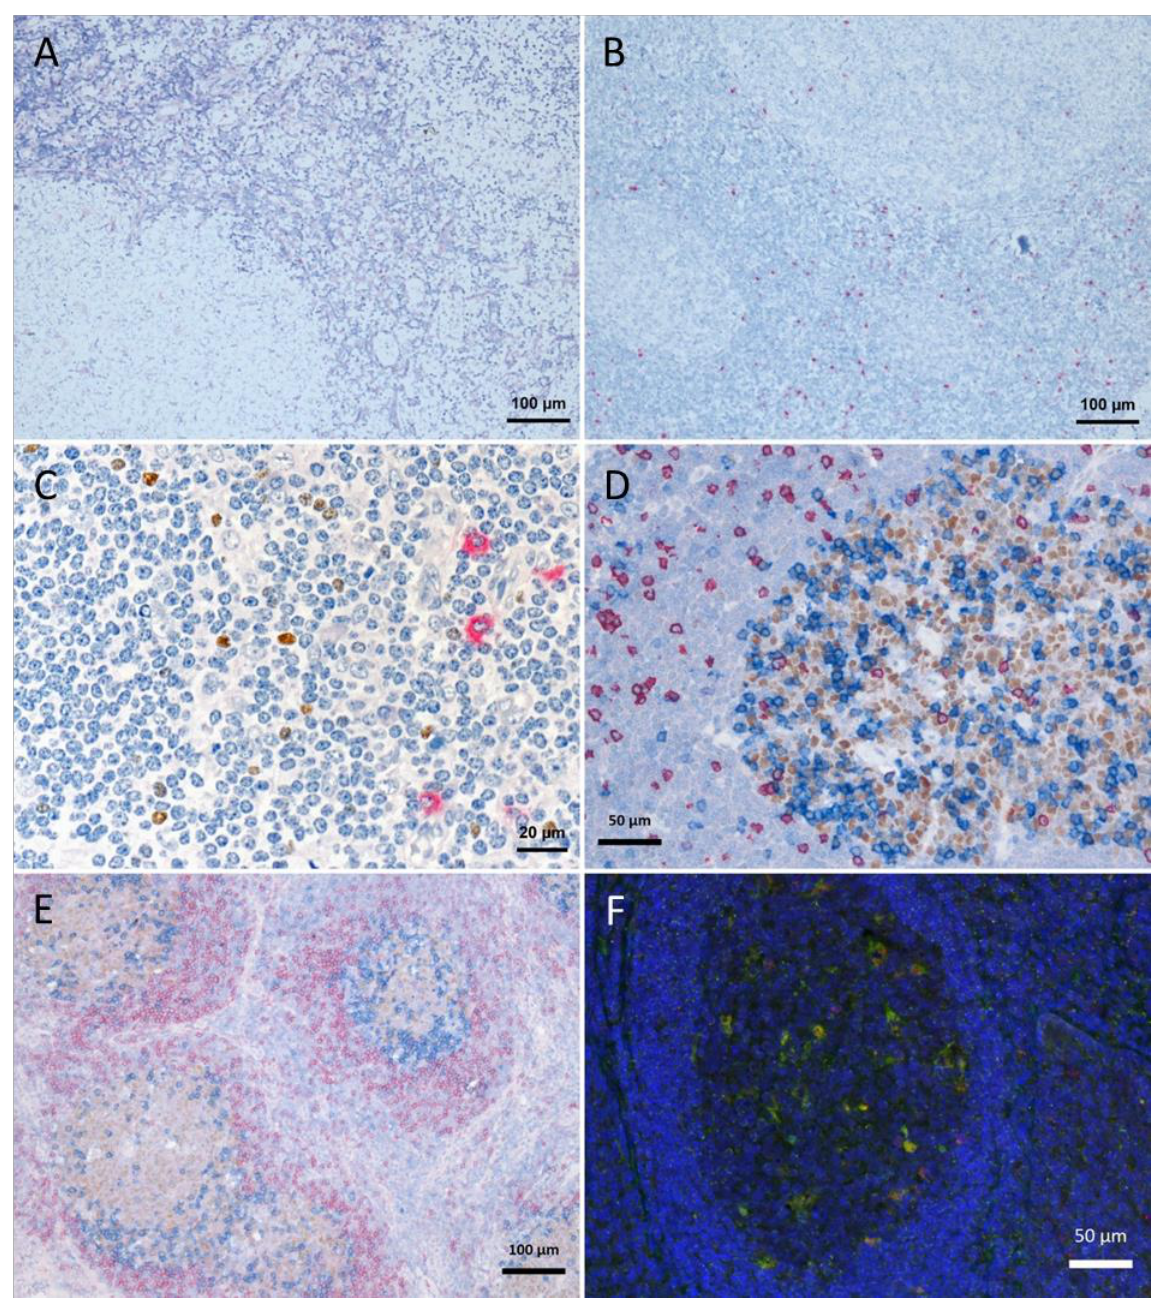
Figure 1. Tissue degradation and signal loss vs. preserved tissue and signal with refixation. ( A ) FoxP3 staining (brown) after 5 min retrieval in high pressure cooker in citric buffer pH 6, followed by KLRG1 (red) after proteinase K pretreatment and ( B ) vice versa (proteinase K followed by high pressure cooking) lead to strong tissue degradation. ( C – F ) show examples with refixation between the retrievals. ( C ) Protocols from ( B ) with interposed refixation step lead to preservation of tissue structure with maintained signals (KLRG1 red, FoxP3 brown). ( D , E ) Examples of triple staining with up to two retrievals: ( D ) human tonsil, CD8 (red, 2 min high pressure cooking) followed by Bcl6 (brown, 5 min high pressure cooking) together with PD1 (blue, cocktail with Bcl6); ( E ) human lymph node, IgD (red, without retrieval), followed by Bcl6/PD1 (brown and blue, respectively, after 5 min high pressure cooking). ( F ) immunofluorescence in human tonsil: LAMP1 (488 green, after 15 min TRIS pH 9 retrieval), ADA2 (555 red, after 20 min TRIS pH 6.1 retrieval), nuclear counterstain with DAPI (blue